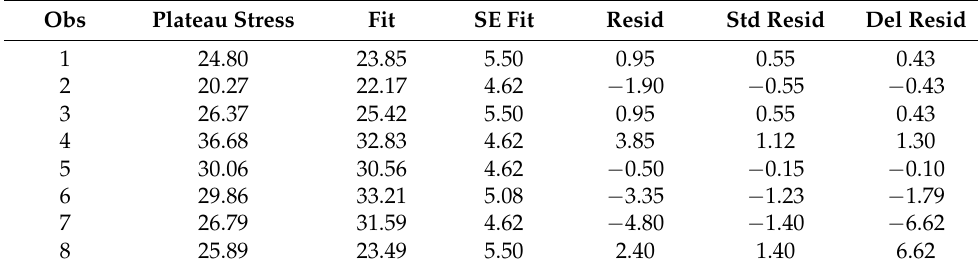
Figure 9. Evaluation of experimental and modal predicted ( a ) plateau stress and ( b ) energy absorp- tion capacity. Table 7. Fits and diagnostics for all observations for plateau